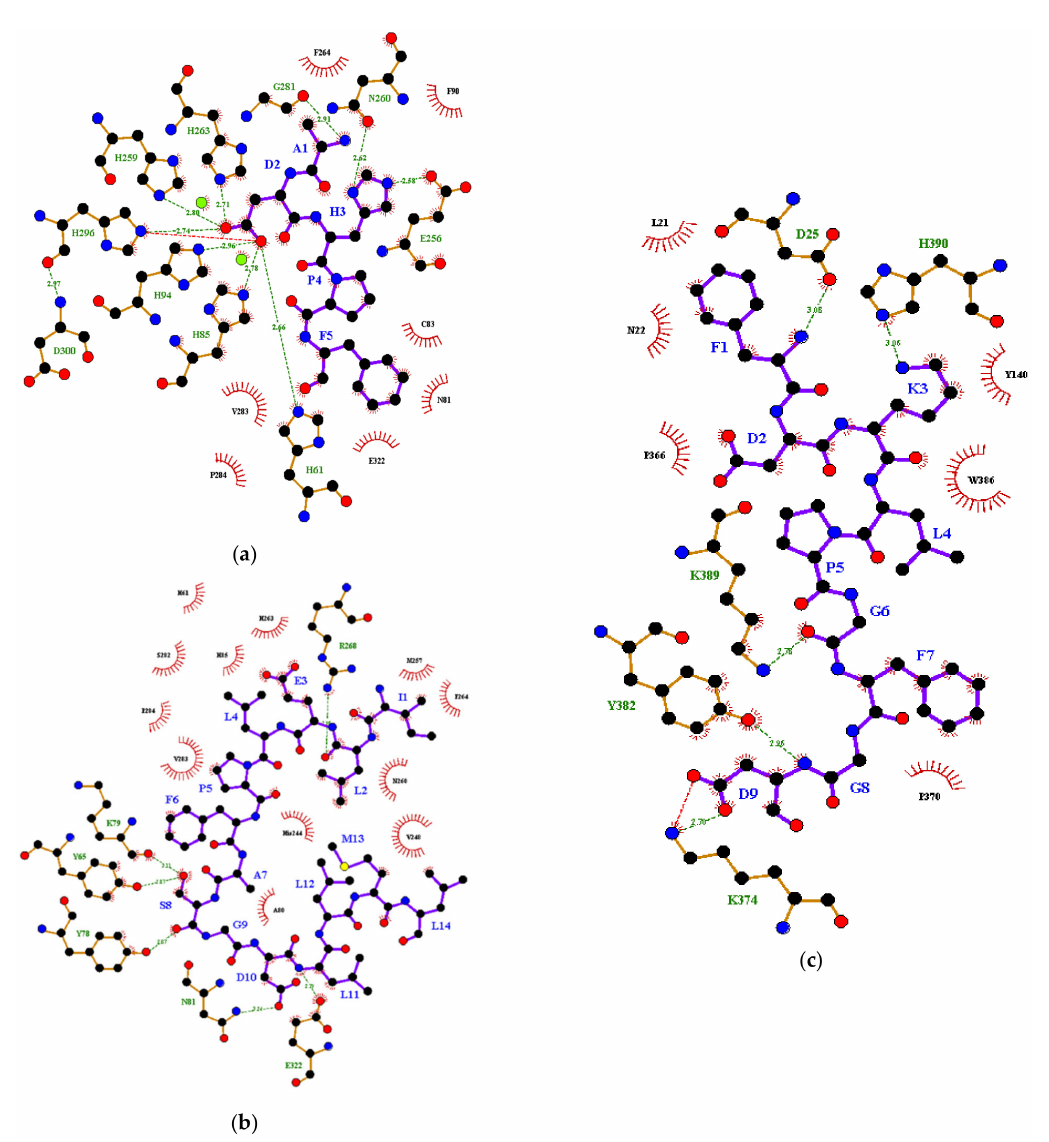
Figure 3. Binding interactions between ( a ) MIP1, ( b ) MIP2, ( c ) MIP3 and tyrosinase during the monophenolase reaction. Red ball, oxygen atom; green ball, copper atom; blue ball, nitrogen atom; black ball, carbon atom; yellow ball, cysteine atom; purple line, peptide; brown line, tyrosinase; cyan line, covalent bond; red dotted line, salt bridge; green dotted line with number, hydrogen bonding and the distance (in Armstrong, Å) between the proton donor and acceptor; Brick red eyelashes, hydrophobic